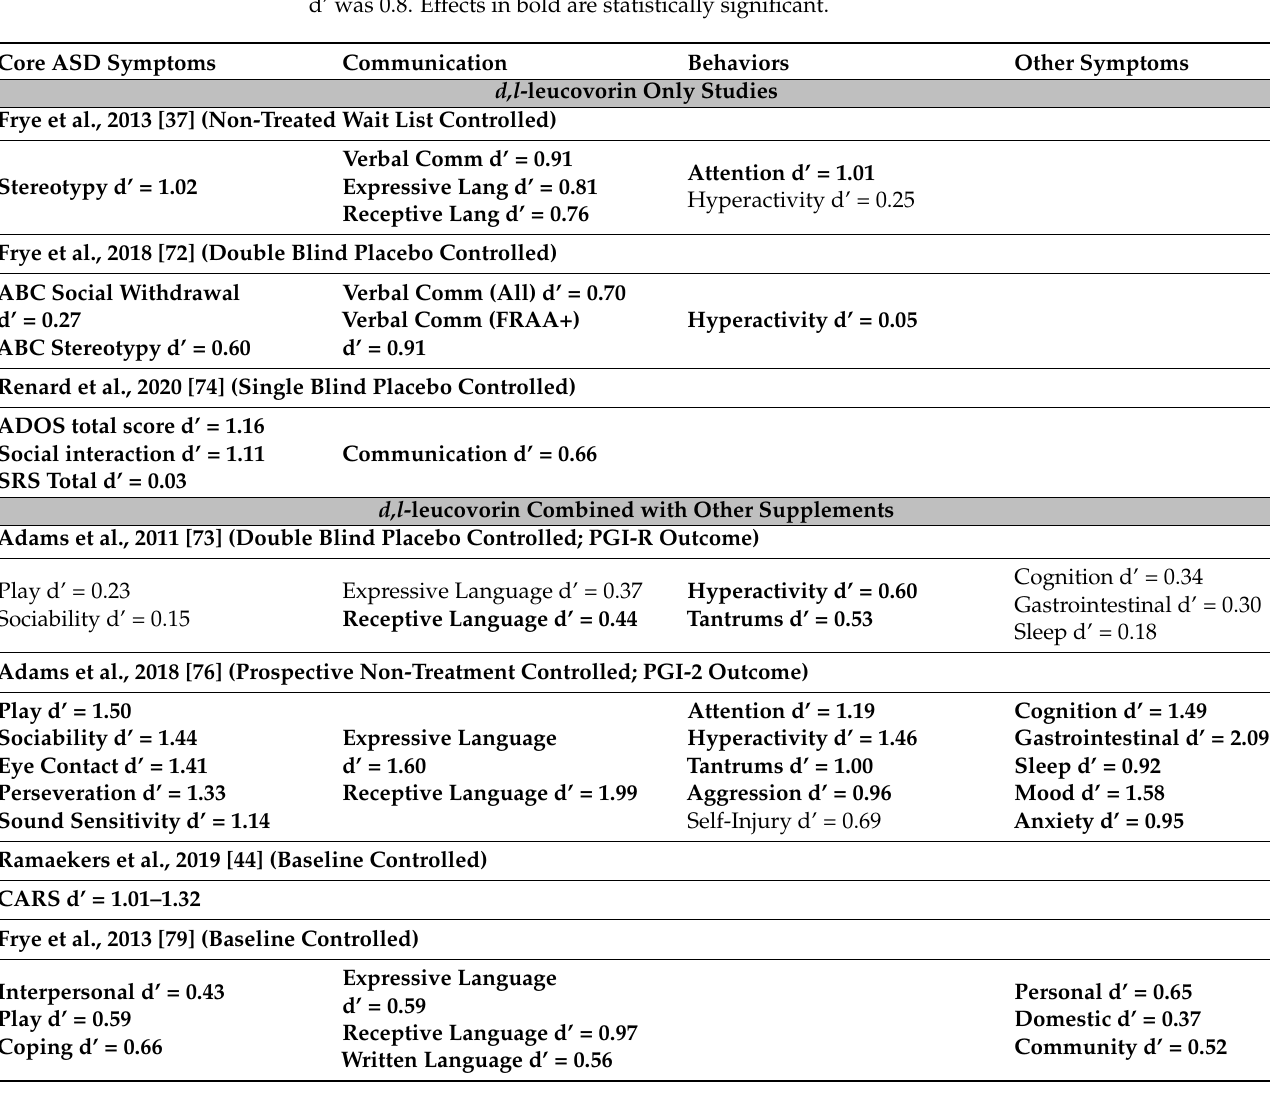
Table 4. Outcome measures represented in effect size in key studies which have used d,l -leucovorin. Cohen’s d’ was calculated for studies which provided enough information to make such calculations. For controlled studies, the effect size represented the difference between the treatment and the control group, whereas for uncontrolled studies, the effect size was calculated only for the treatment. Effect sizes were considered small if Cohen’s d’ was 0.2; medium for Cohen’s d’ of 0.5, and large if Cohen’s d’ was 0.8. Effects in bold are statistically